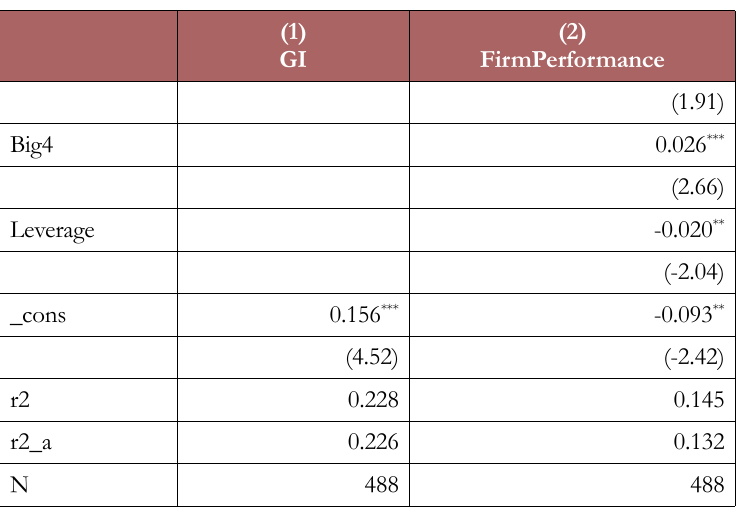
Table 3. Regression Results of Green Innovation and Firm Performance